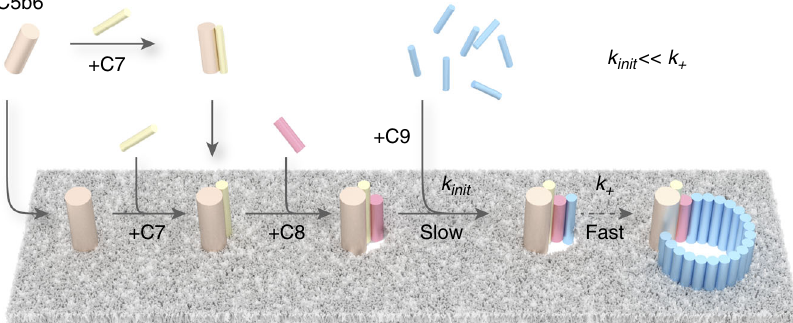
Fig. 5 Schematic of MAC assembly. Upon formation, C5b6 templates the assembly, recruiting C7 and C8 to the nascent MAC. The C5b-7 complex is irreversibly bound to the membrane. Insertion of the fi rst C9 is the rate limiting step in the MAC assembly; once this barrier has been overcome, subsequent C9 binding/insertion occurs more than two orders of magnitude faster than the initial C9